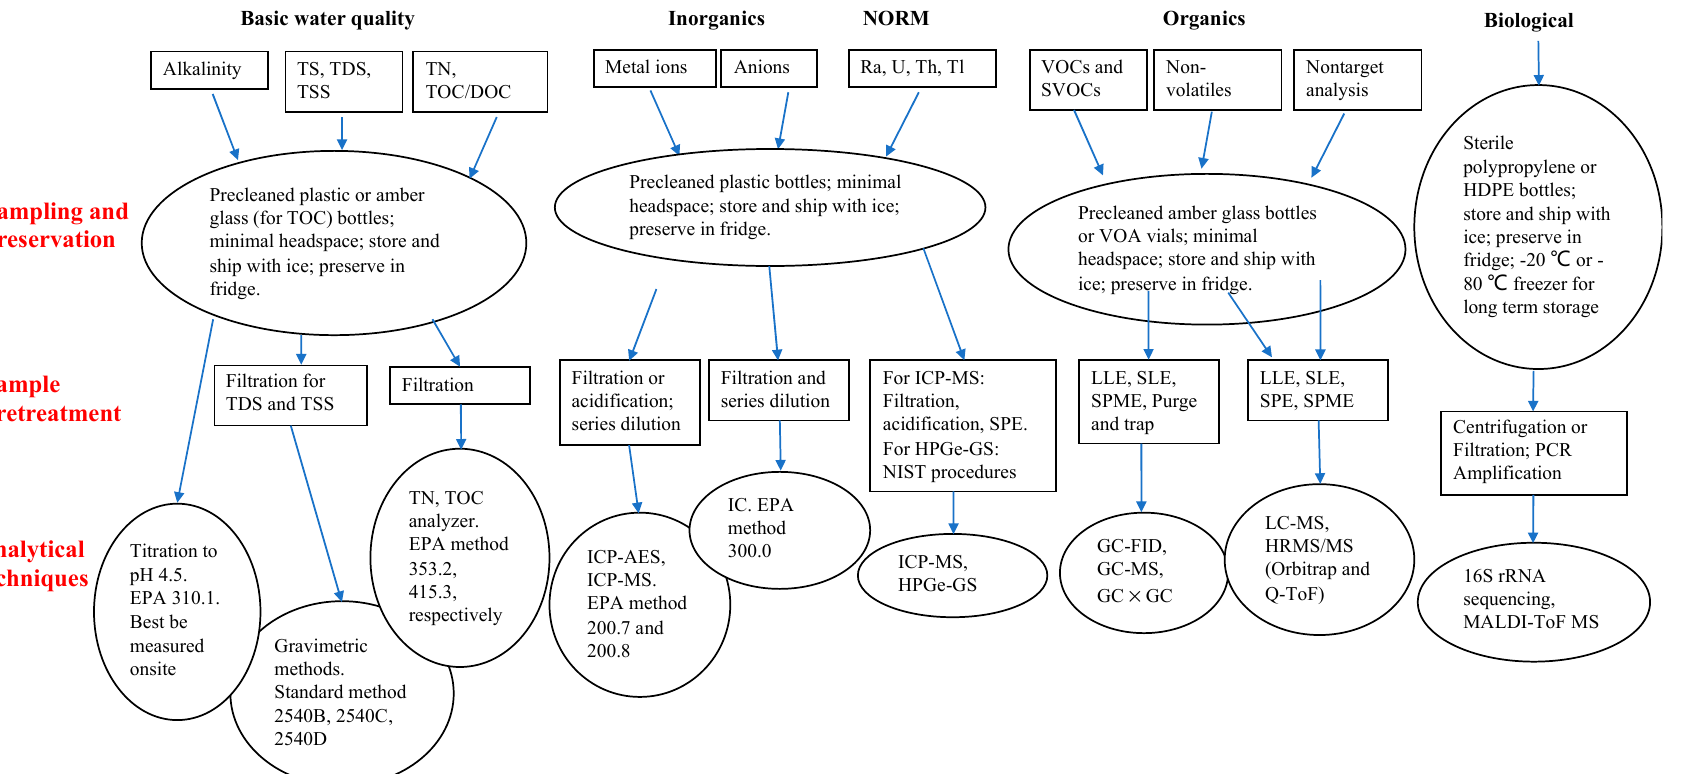
Figure 4. Proposed approaches for analysis of chemical constituents in flowback and produced water.